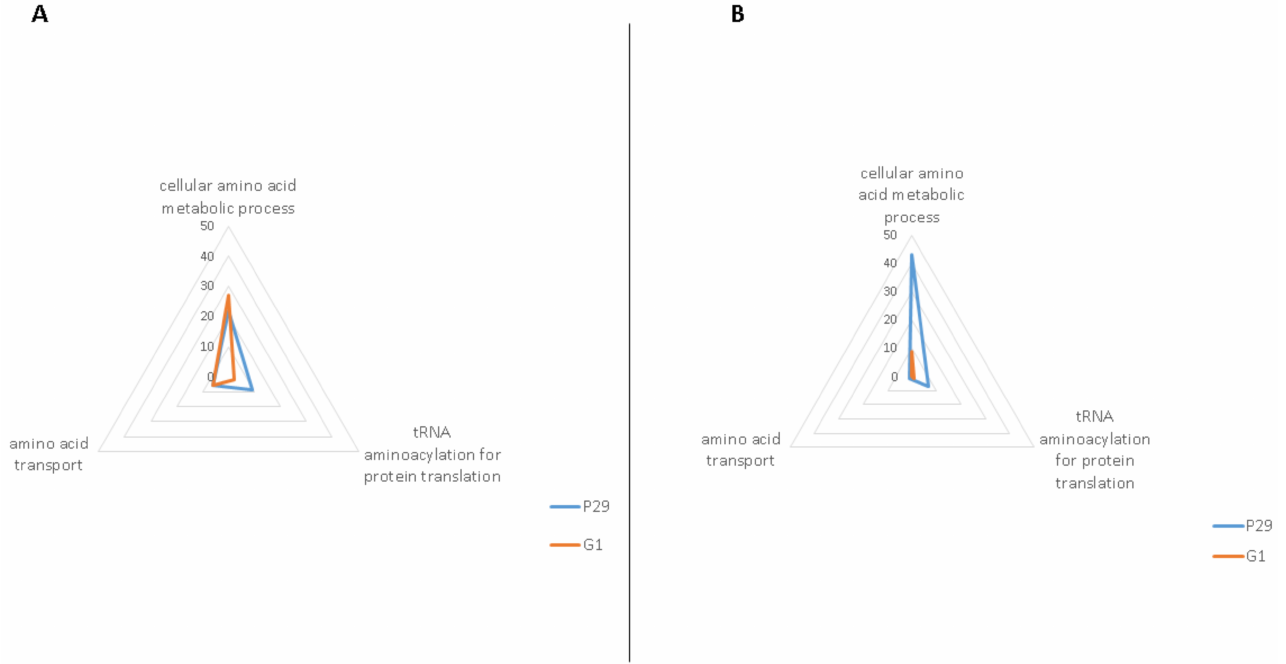
Figure 1. Total number of specific proteins related to amino acid metabolism in S. cerevisiae P29 (blue colour) and G1 (orange colour) during two sampling times: at the middle of the second fermentation, MF ( A ), and at the end of the second fermentation, EF ( B